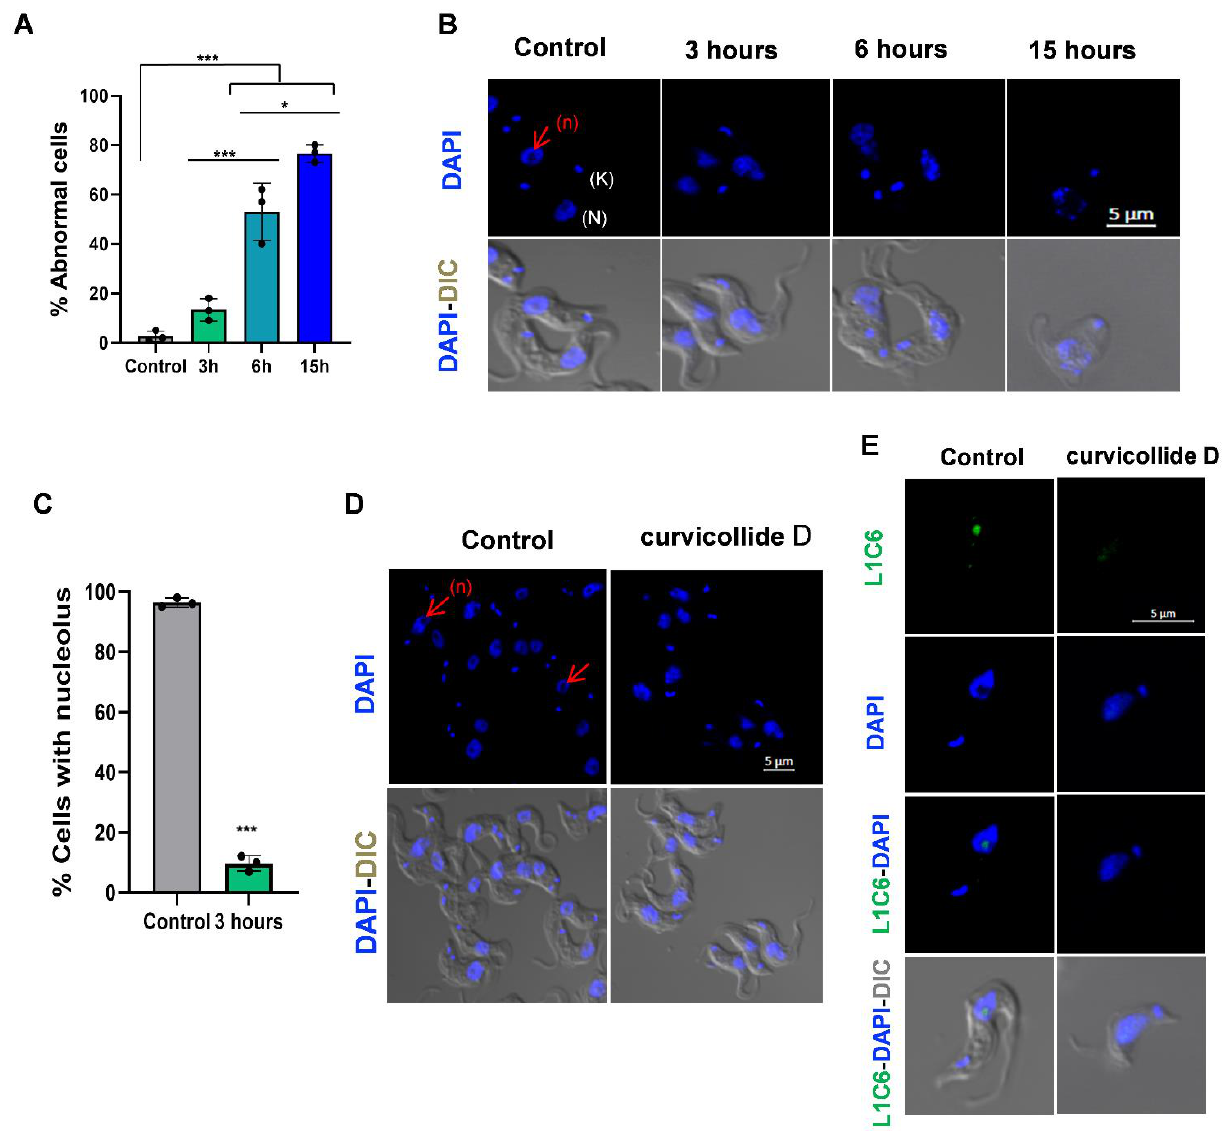
Figure 5. Changes in cell morphology and nucleolar structure after 3, 6 and 15 h of treatment with curvicollide D. Bloodstream forms of T. brucei incubated with 1.5 µ M of Curvicollide D for 3, 6 and 15 h and cells treated with DMSO (control). ( A ) Percentage of abnormal cells. Error bars represent the standard deviations from three independent experiments. Statistical significance was *, p < 0.05; ***, p < 0.001 using ANOVA and Bonferroni post hoc test. ( B ) Changes in cell morphology after 3, 6 and 15 h of treatment. DAPI-stained parasites were observed by confocal microscopy (top line) and so was differential interference contrast (DIC) with DAPI (bottom line). The nucleus (N) and kinetoplast (K) are shown in white. The arrow in red indicates the nucleolus (n). ( C ) Percentage of cells that maintain the nucleolus structure after treatment. ( D ) Confocal microscopy showing disassembly of the nucleolus after a 3 h treatment with curvicollide D. ( E ) Immunofluorescence microscopy using an antibody against the nucleolar marker L1C6 (green) after a 3 h treatment with curvicollide D. Scale bar, 5 µ m. Statistical significance between control and 3 h of treatment was estimated using Student’s two-tailed t -test. p -Value was expressed as follows: *** p < 0.001.